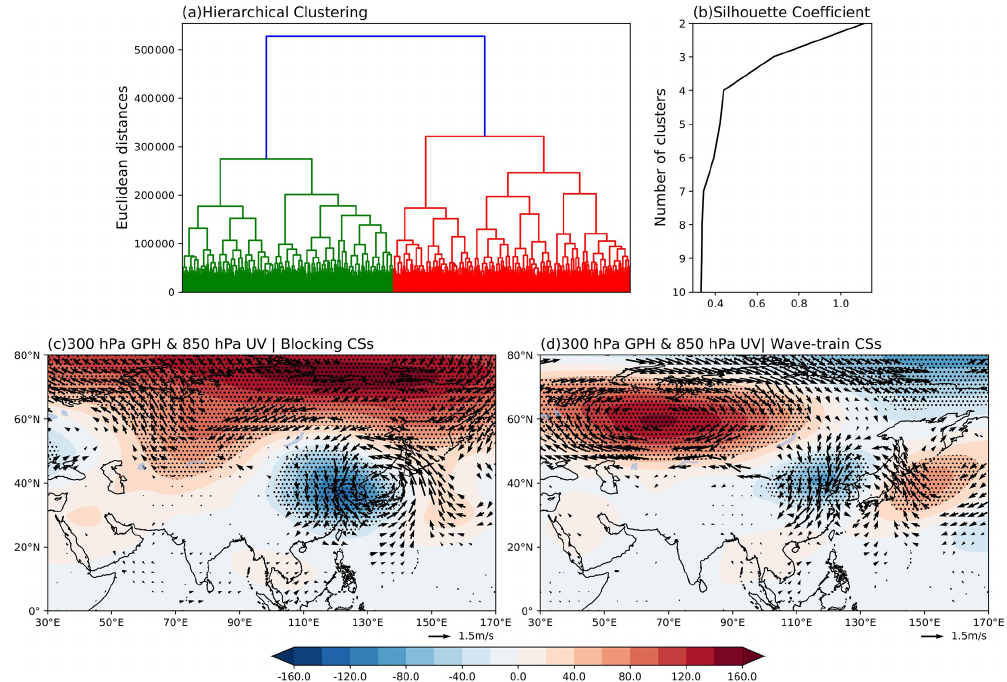
Figure 3. Hierarchical clustering tree (a) and silhouette coefficient (b) of cool-season CSs in the EC. Composite of GPH anomalies at 300hPa (shading; gpm; dotted areas are statistically significant at the 95% confidence level) and horizontal wind anomalies at 850hPa (vectors; ms − 1 ; only the areas are shown which are statistically significant at the 95% confidence level) relative to blocking CSs (c) and wave-train CSs (d)